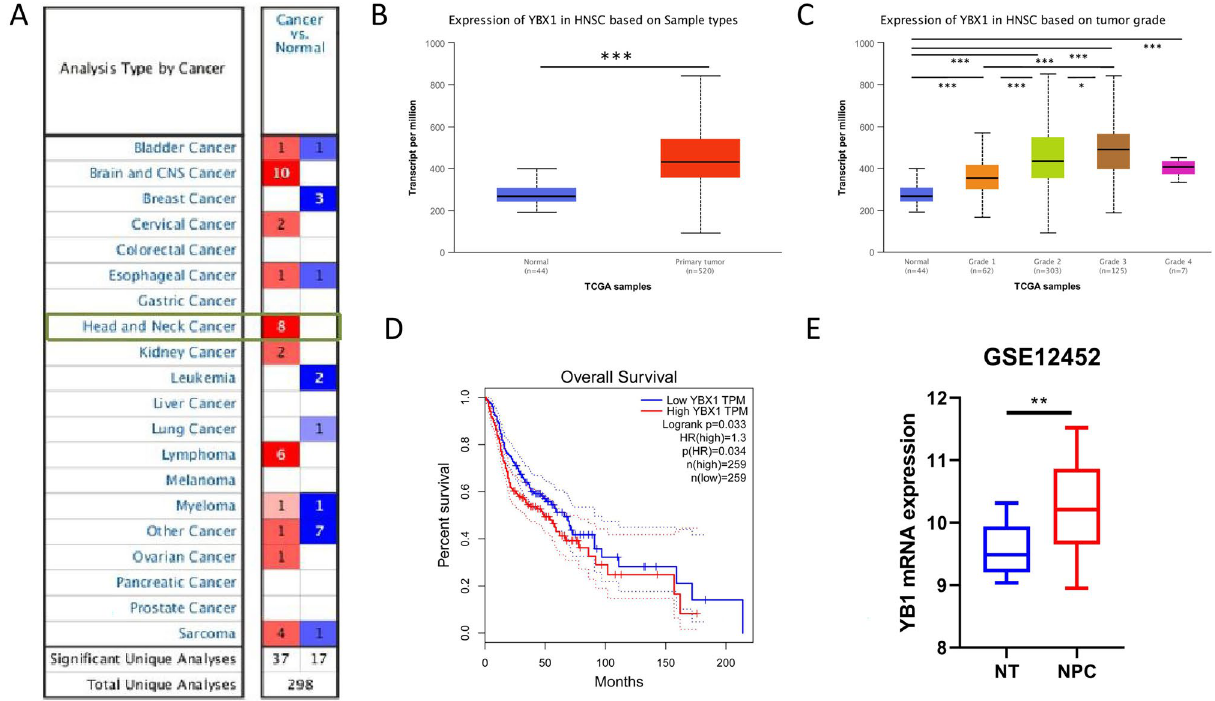
Figure 1. Significant higher expression of YBX1 mRNA in patients with head and neck cancer (HNSC) and nasopharyngeal carcinoma (NPC) by bioinformatic analysis. ( A ) Transcriptional expression of YBX1 in 20 types of cancer (ONCOMINE database); ( B ) mRNA expression of YBX1 in HNSC tissues and corresponding normal tissues (UALCAN database); ( C ) Relationship between mRNA expression of YBX1 and tumor grade of HNSC patients (UALCAN database); ( D ) Prognostic value of mRNA expression of YBX1 in patients with HNSC (GEPIA database); ( E ) Transcriptional expression of YBX1 in NPC tissues and corresponding normal tissues (GEO database, GSE